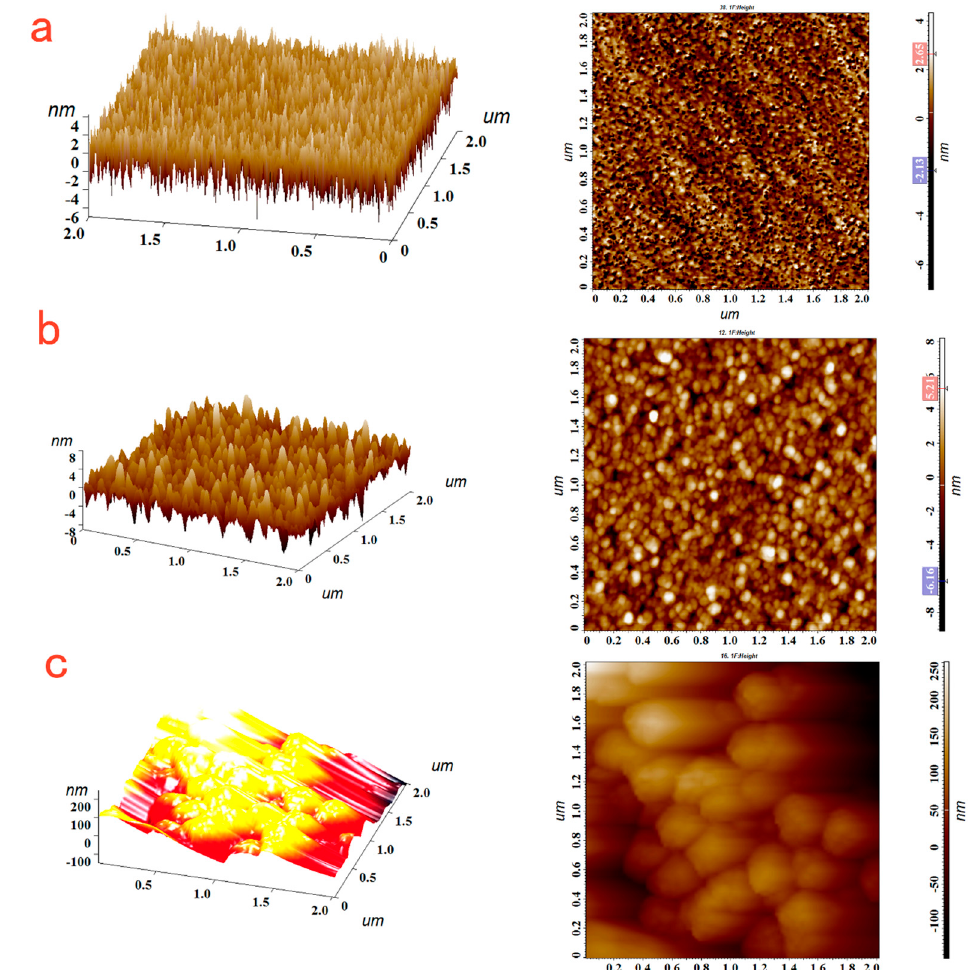
Figure 5. The AFM picture of the bare film ( a ); the AFM picture of the T2 − OVA immobilized on the surface of the chip ( b ); the AFM picture of mAb − Fe 3 O 4 @SiO 2 @AuNPs binding to the surface of the chip ( c ).